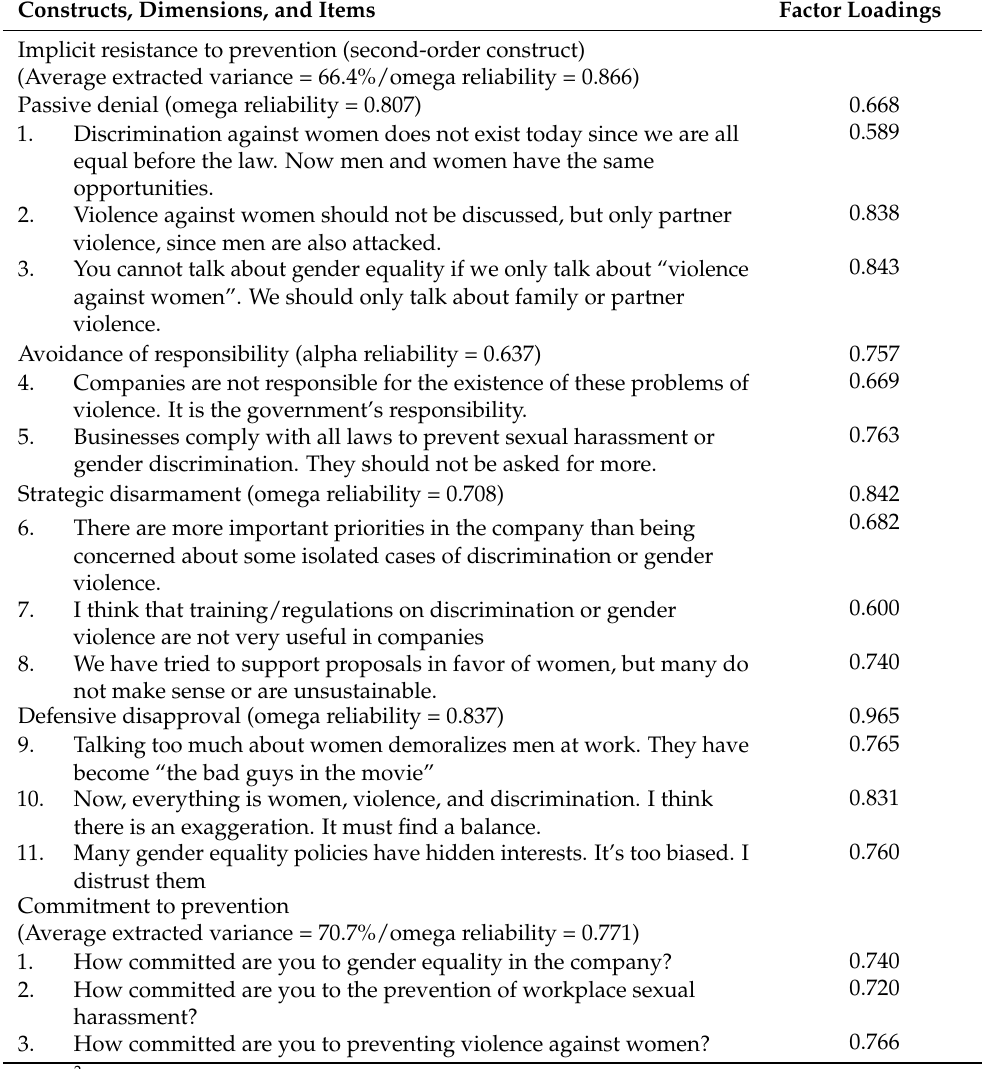
Table 1. Confirmatory factor analysis of the implicit resistance to prevention and commitment to prevention